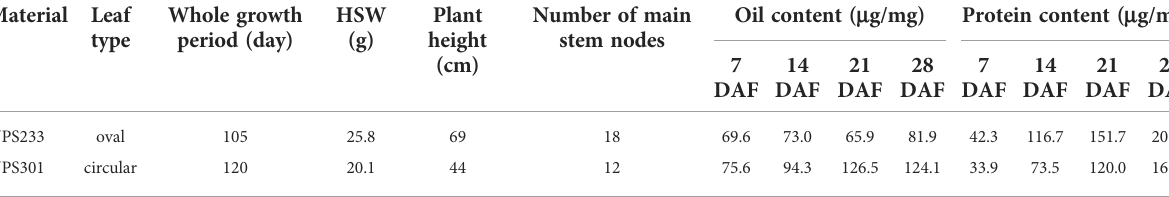
TABLE 1 Phenotypic differences between ‘ NPS233 ’ and ‘ NPS301 ’ . Material Leaf